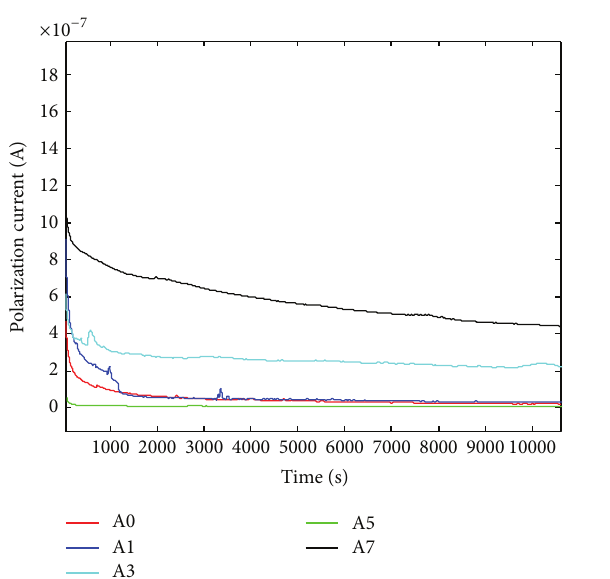
Figure 6: Depolarization current values for samples A0, A1, A3, A5, and